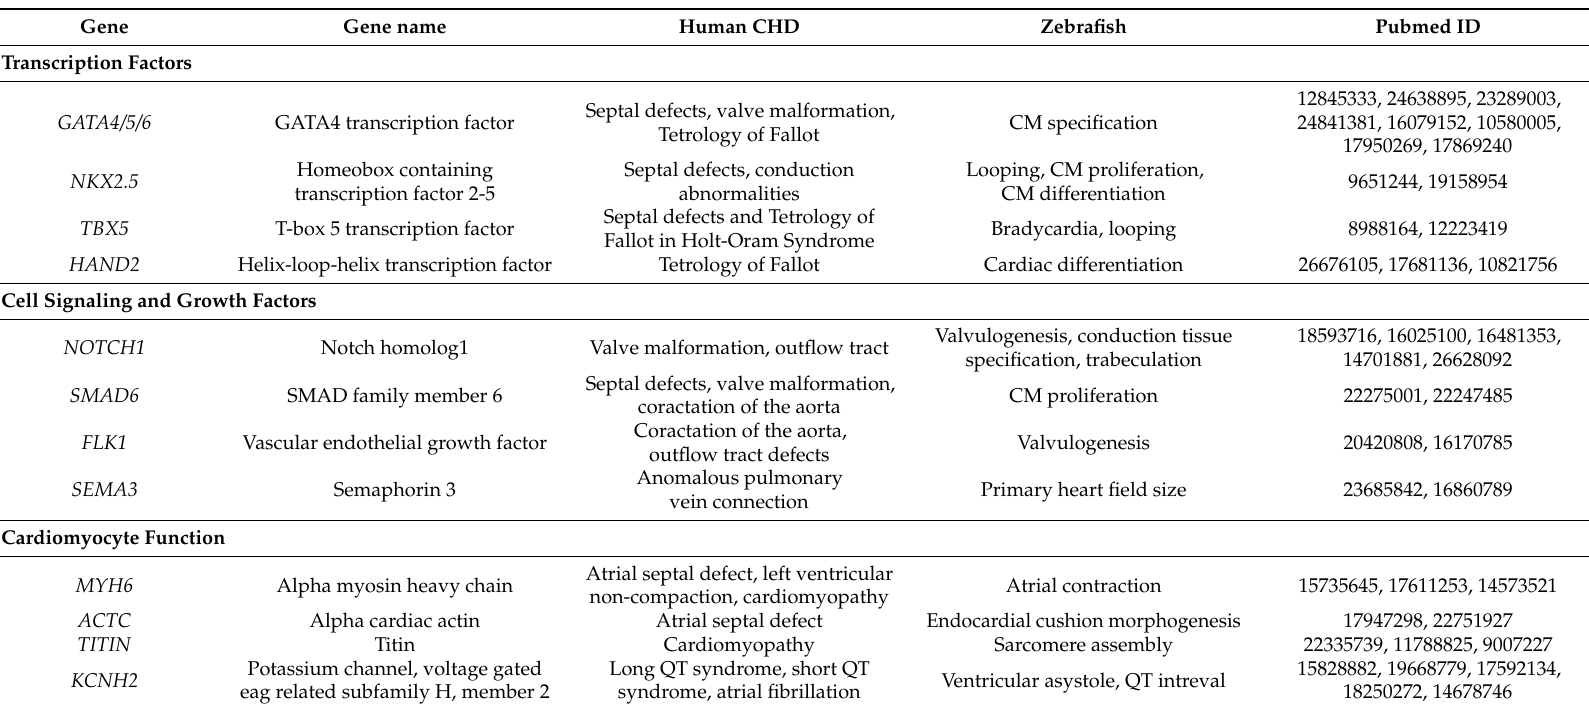
Table 1. List of human congenital heart diseases (CHD) genes and their zebrafish